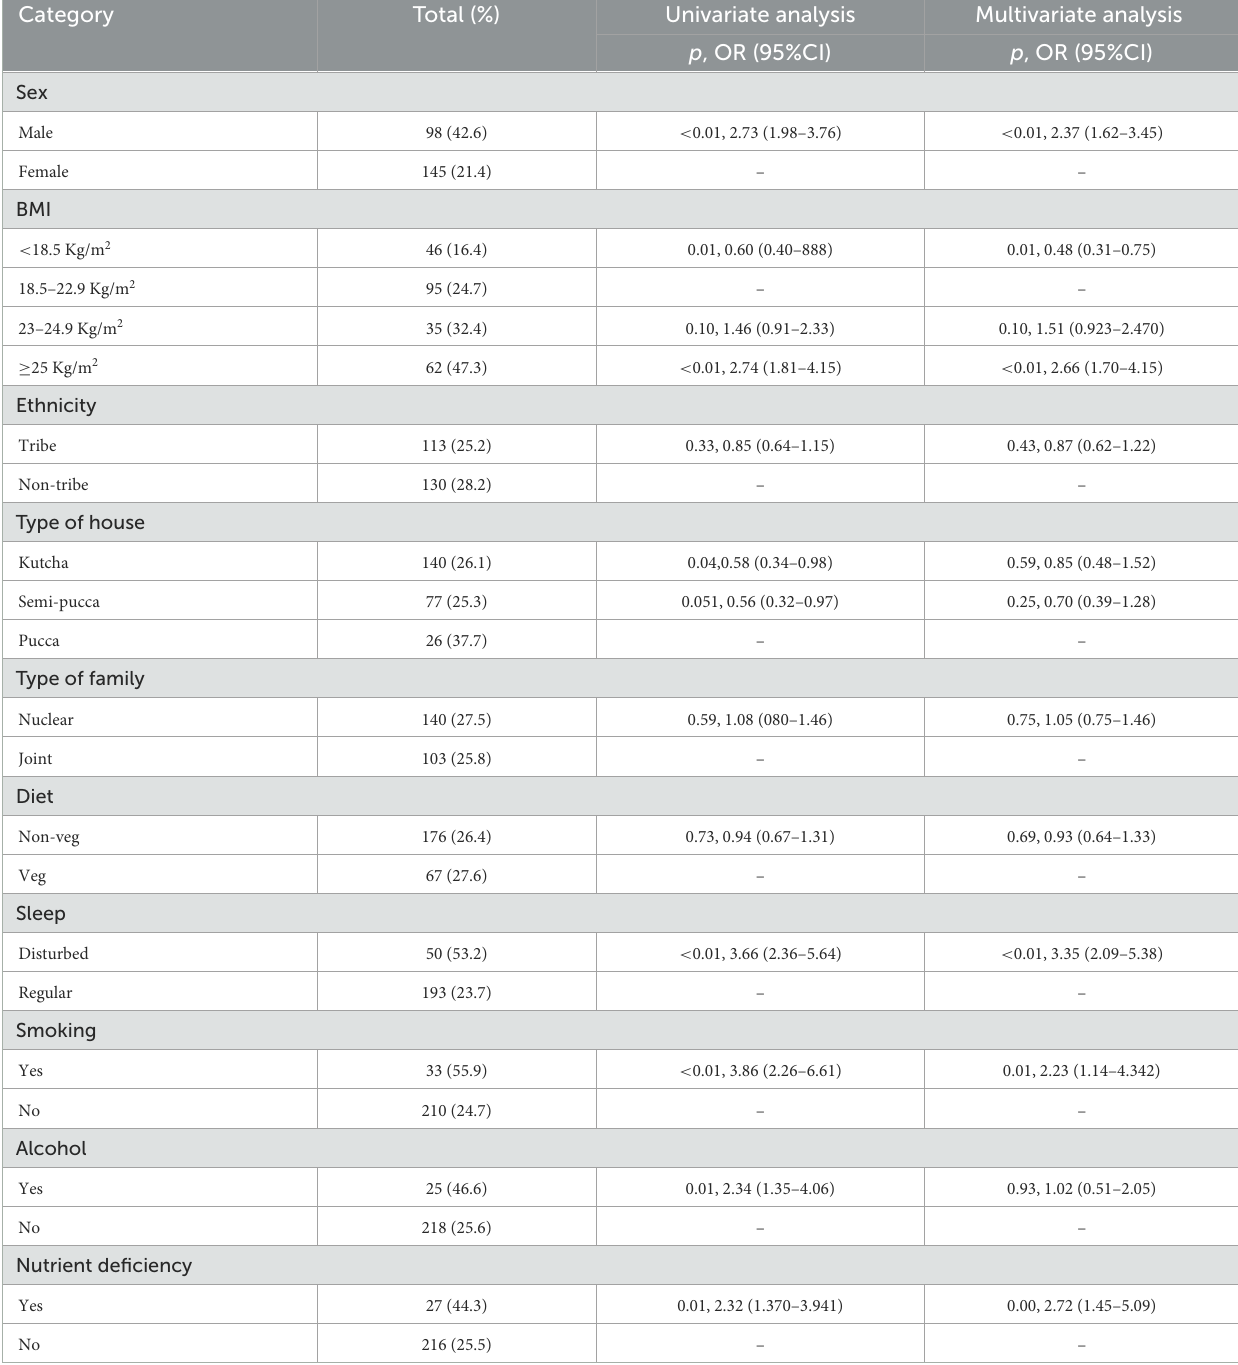
TABLE 4 Risk factors associated with the non-communicable disease among study participants.